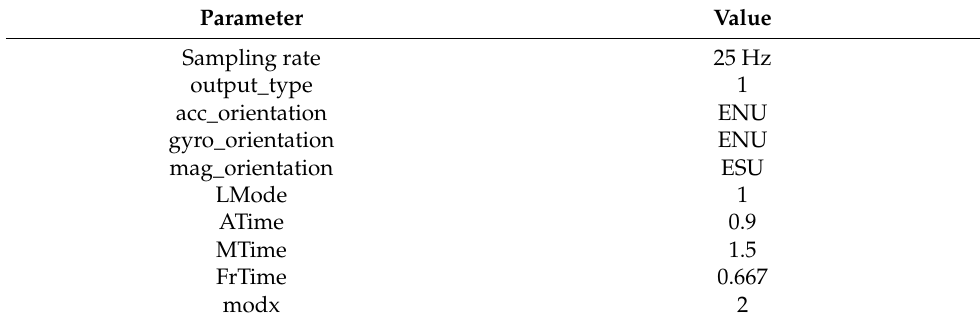
Table 2. Configuration parameters of